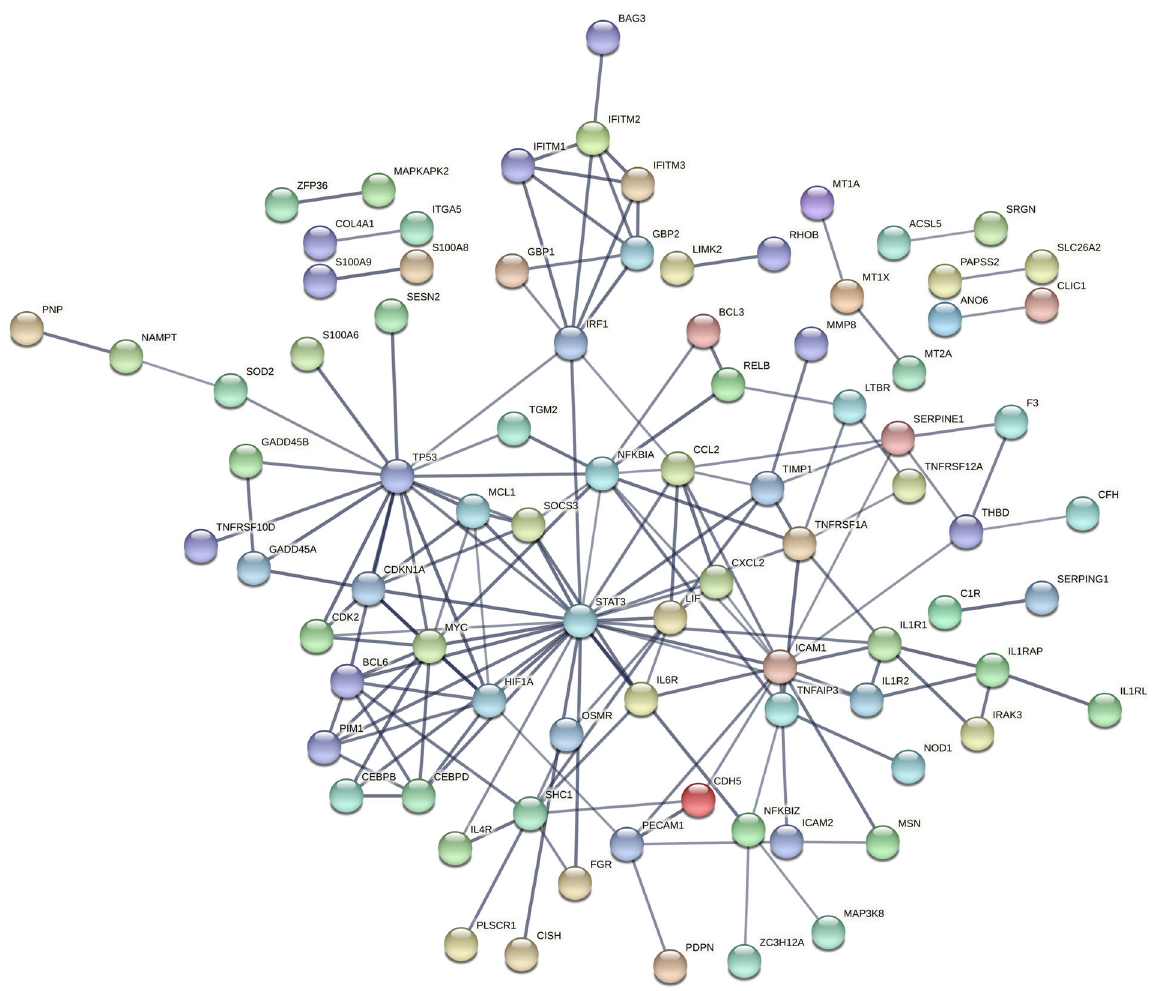
Fig. 3 Network Plot of Co-Expressed Genes in AUD-associated Modules. Network plot of genes, co-expressed between the WGCNA modules e-CN-magenta, e-PUT-black and